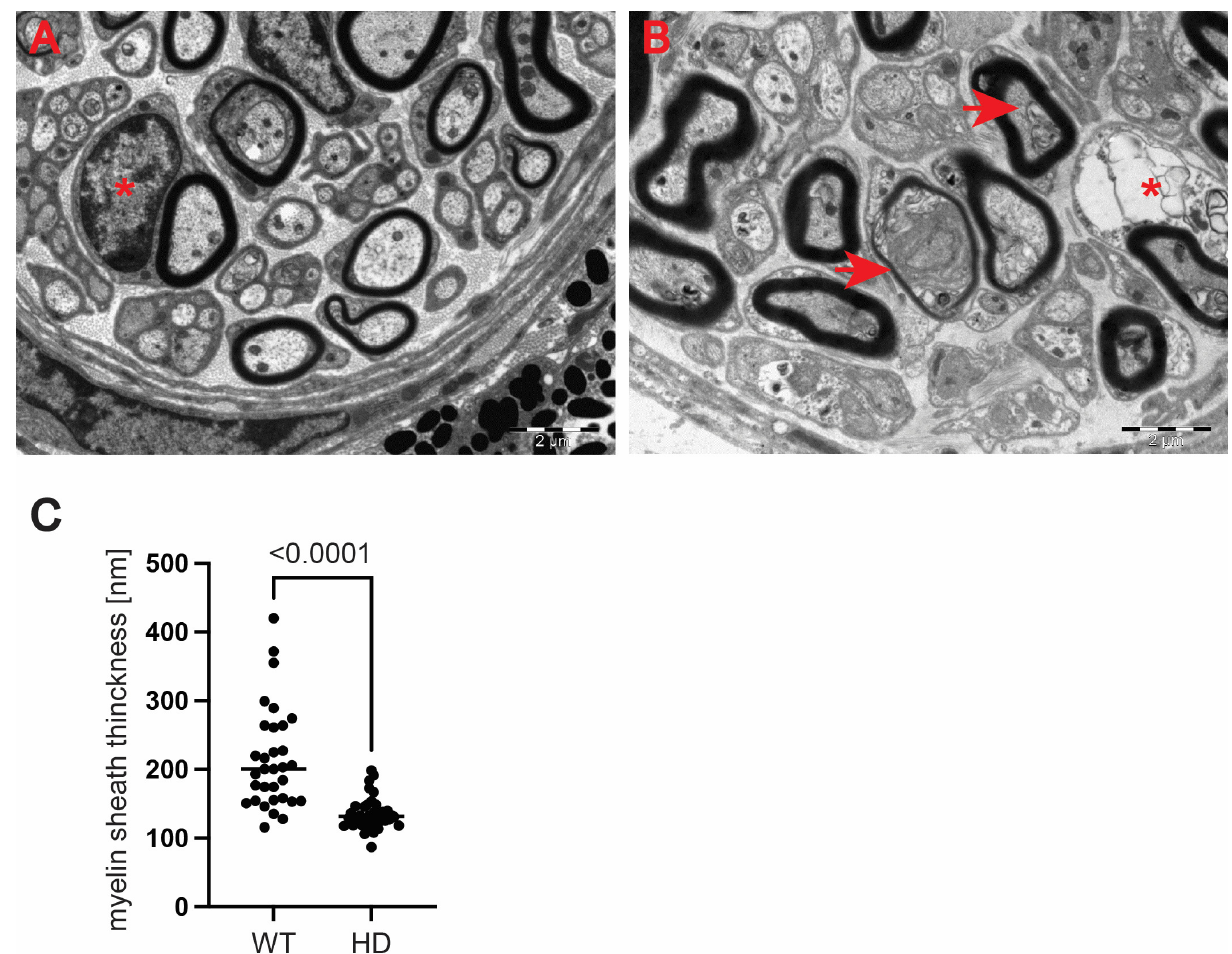
Figure 6. Structural abnormalities of the peripheral nerve structures in symptomatic R6/2 mice. ( A ) A representative electron microscopy pictogram of the choroids area in the wild-type mice. Axons display correct morphology with properly dense myelin sheaths. The cells exhibit a normal distribution and morphology of typical cellular components such as mitochondria, neurotubules and neurofilaments. A typical Schwann cell is indicated with an asterisk. ( B ) A representative electron pictogram from the choroids area in the HD mouse model. An abnormal Schwann cell is presented with a degenerated cytoplasm with an apparent oedema and vacuolisation (asterisk). HD axons display progressive degeneration of the myelin sheath with apparent shrinkage of axons (arrowheads). ( C ) A significant reduction in the myelin sheaths’ thickness in the symptomatic R6/2 mice in comparison with their littermates. Error bars are ± SD (n > 100). One-way ANOVA with Bonferroni post hoc test.